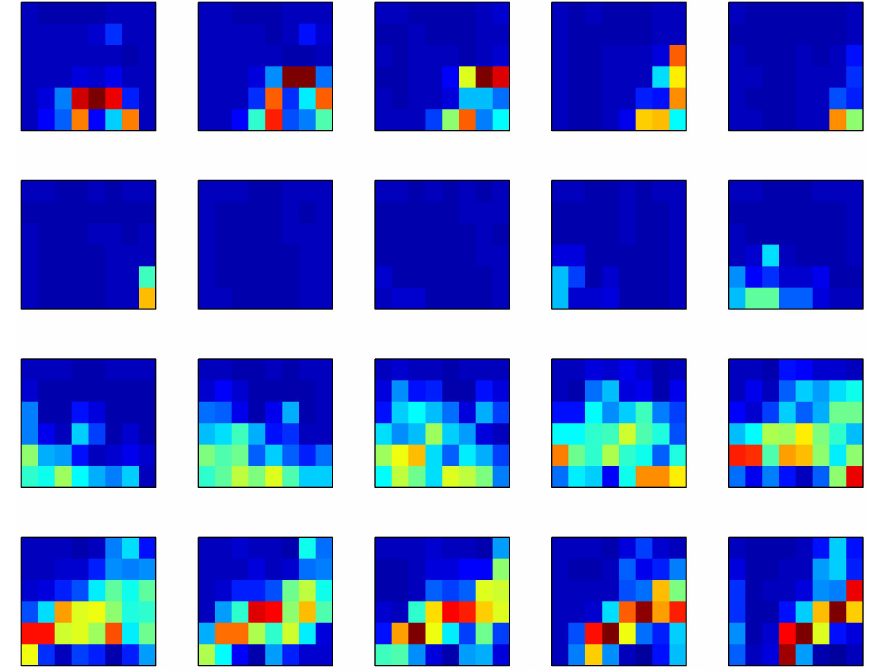
Fig. 3. Time series images of 40 × 40 pixels blocks of standard deviation corresponding to the thermal images shown in Fig. 2. Images are scaled between 0 ◦ C (blue) and 10 ◦ C